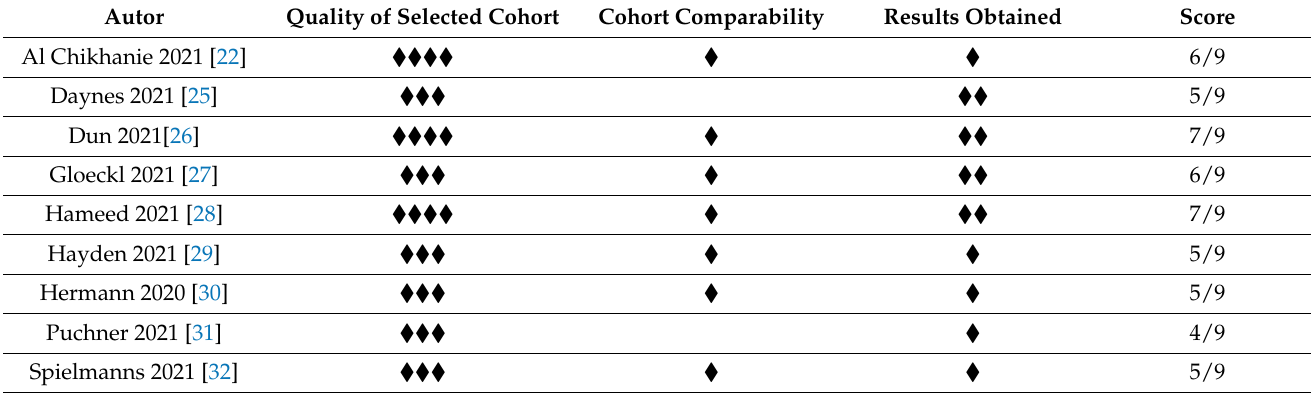
Table 3. NOS for cohort studies and prospective observational studies.